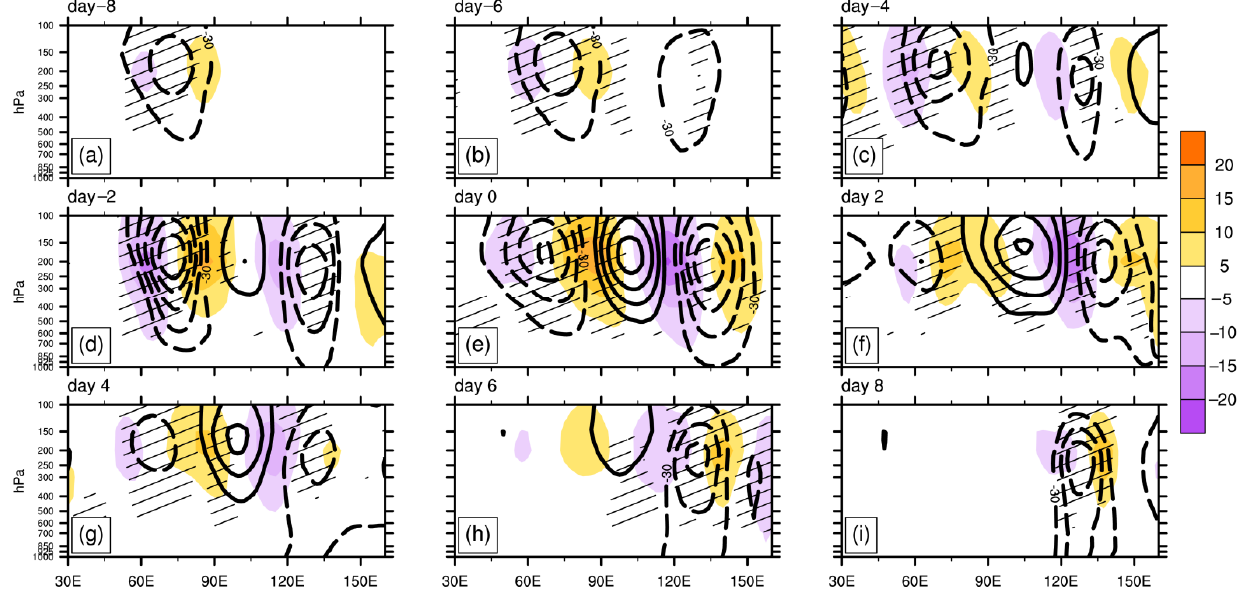
Figure 6. The same as in Figure 5, but for the SRP−